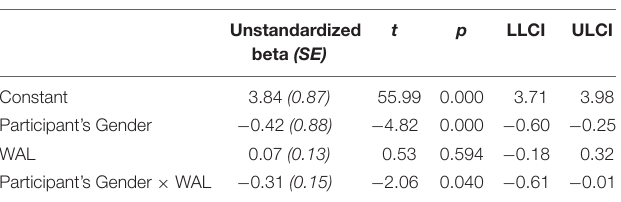
TABLE 2 | Study 1 regression results.